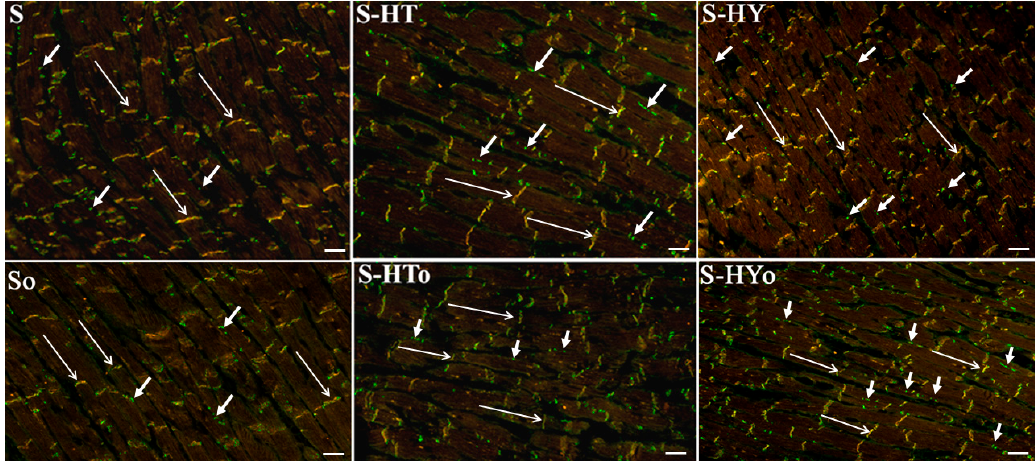
Figure 4. Topology of myocardial connexin-43 (Cx43, green) colocalized with N-cadherin (red) in the male hypertensive rats with altered thyroid status with or without feeding with Omacor; S—spontaneously hypertensive rats; o—fed with Omacor; HT—hyperthyroid rats; HY—hypothyroid rats. Note conventional immunofluorescence labeling of Cx43 and N-cadherin at the gap junctions (long arrows) and Cx43 on lateral surfaces of the cardiomyocytes (short arrows). Objective 40×. Scale bar 10 µm.